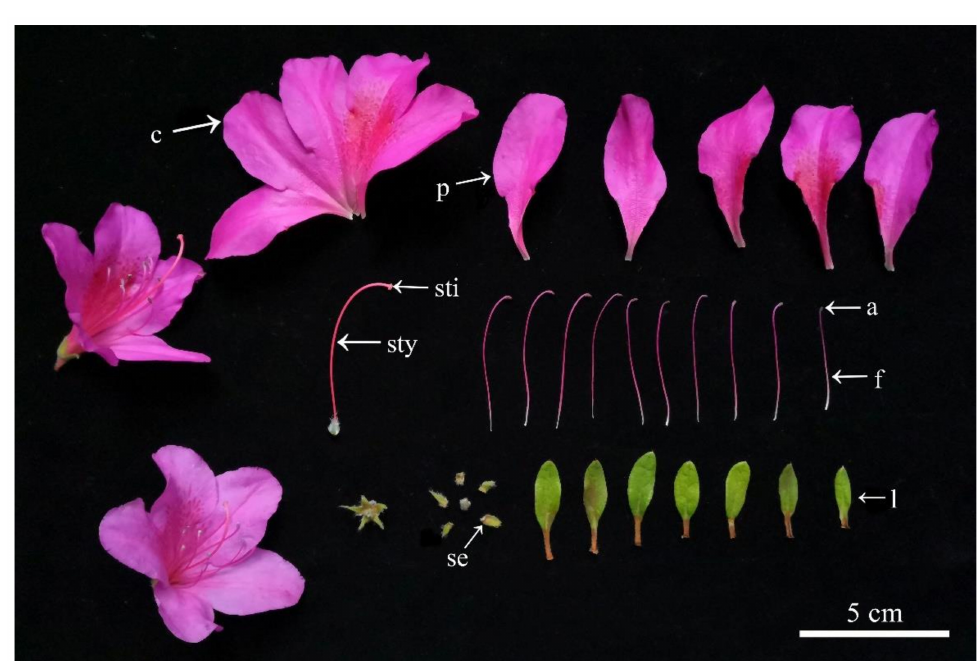
Figure 3. Morphology and composition of floral organs and the leaves. c: corolla; p: petal; sti: stigma; sty: style; se: sepal; a: anther; f: filament; l: